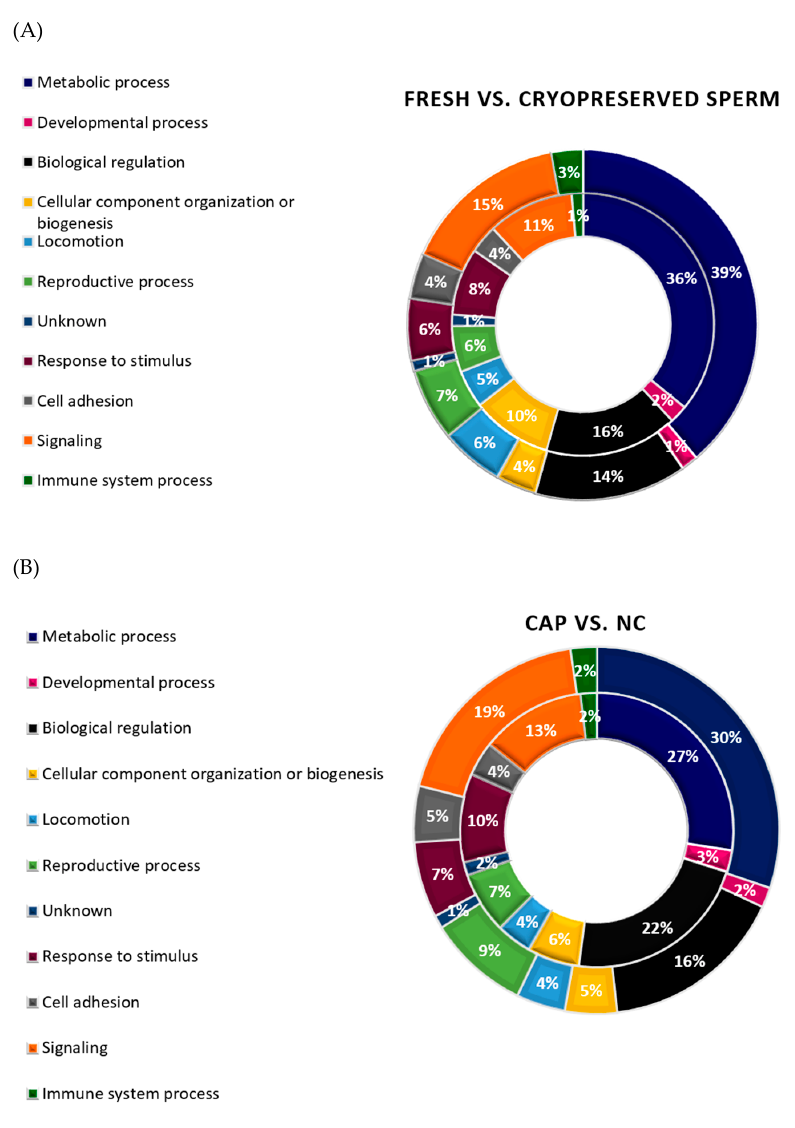
Figure 4. Biological process categorization of ram sperm proteins identified in di ff erent treatments. ( A ) Distribution of those proteins identified in fresh (outer circle) or in cryopreserved sperm (inner circle). ( B ) Distribution of those proteins present in sperm incubated in CAP (outer circle) or NC conditions (inner